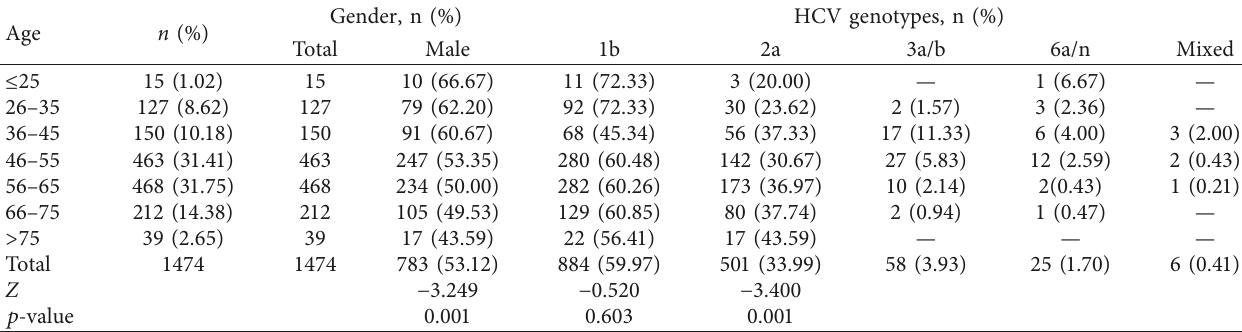
Table 2: Age-wise distribution of gender and HCV genotypes in HCV-infected patients.